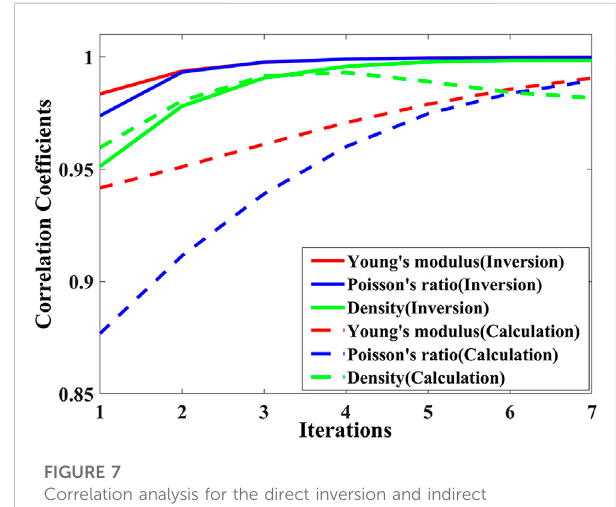
FIGURE 7 Correlation analysis for the direct inversion and indirect calculation.